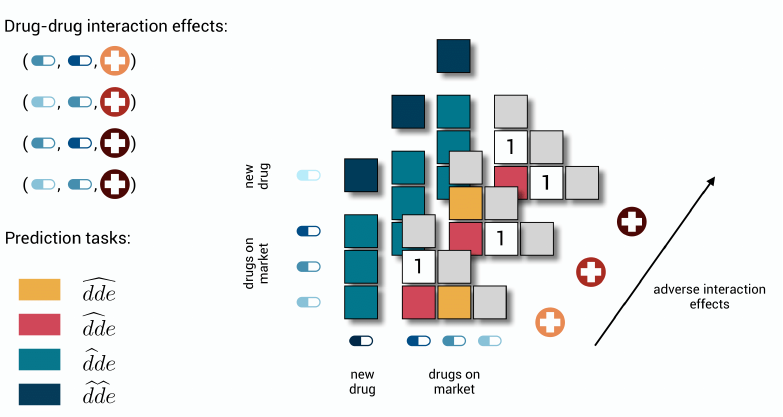
Figure 1. The different tasks in a toy polypharmacy prediction problem. There are three possible adverse effects and three drugs on the market for which two different pairwise combinations are labeled to cause two specific adverse effects. Because of symmetry, it is sufficient to only store values on one side of the diagonal, as the other side is only representing the same combinations with the drugs interchanged. In the first task, the goal is to predict whether also the third specific adverse effect would occur for the two combinations that already have some known effects. In the second, the goal is to predict whether and which effects would occur for the third combination of on market drugs for which no effect is known. In task three, a new drug is added for which no label can yet be found, and one wants to predict whether drug–drug interaction effects would occur in combination with the drugs that are already on the market. In the last task, the goal is to predict whether and which effects would occur when two new drugs are